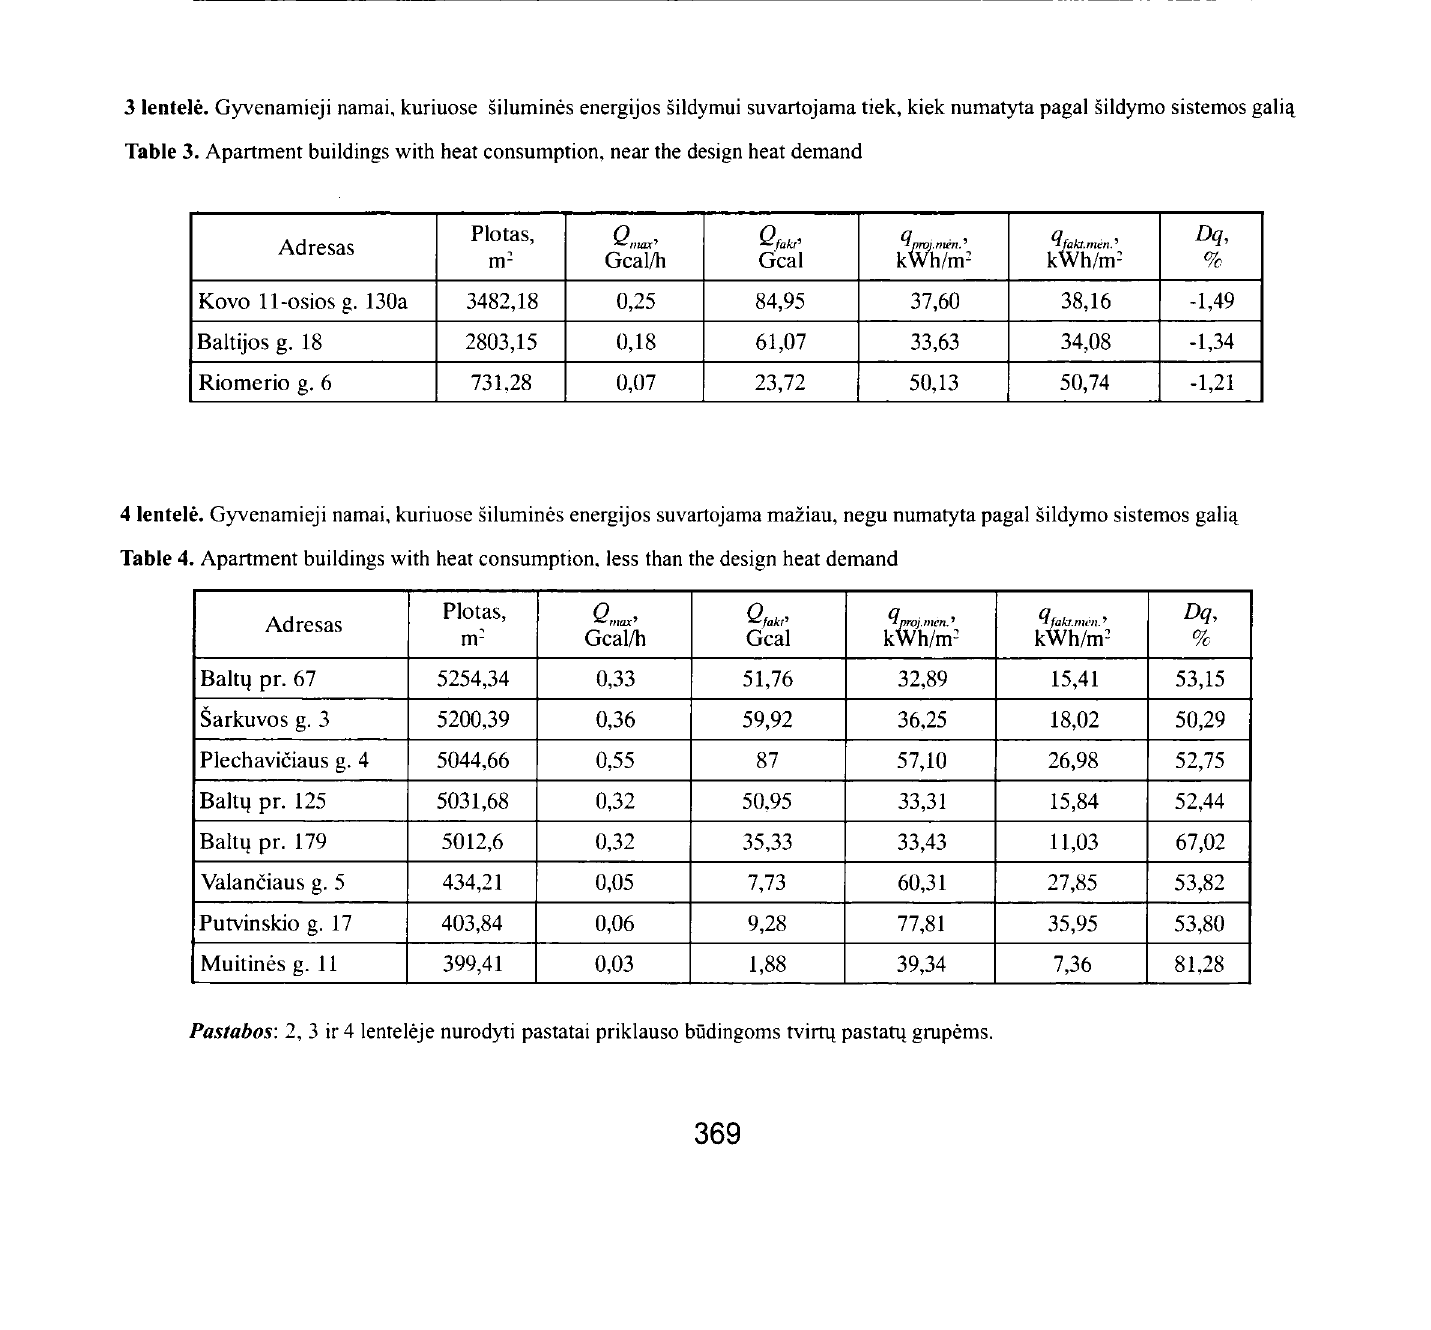
Table 3. Apartment buildings with heat consumption, near the design heat demand